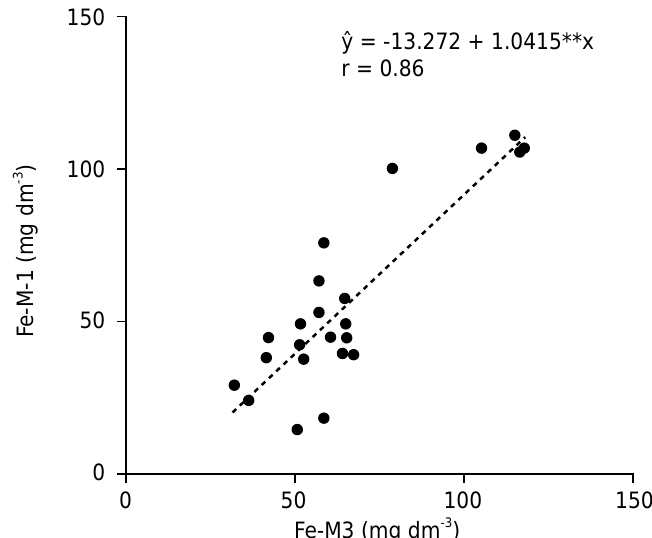
Figure 5. Correlation between the concentrations of Fe obtained by Mehlich-1 (M-1) and Mehlich-3 (M-3). ** : significant at 1 % by the F